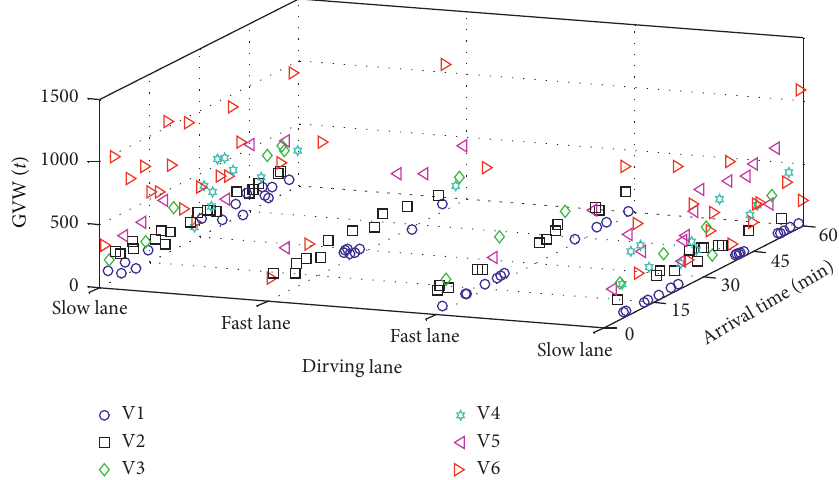
Figure 6: A stochastic vehicle flow sample.